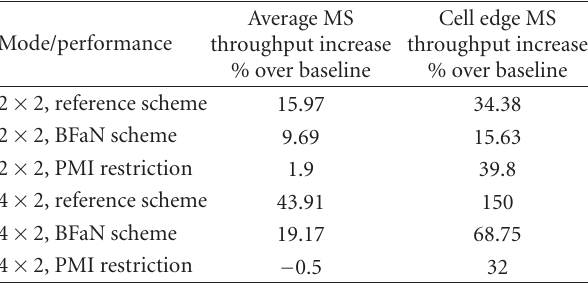
Table 1: Simulation parameters summary. Table 2: Simulation result from BFaN and PMI restriction